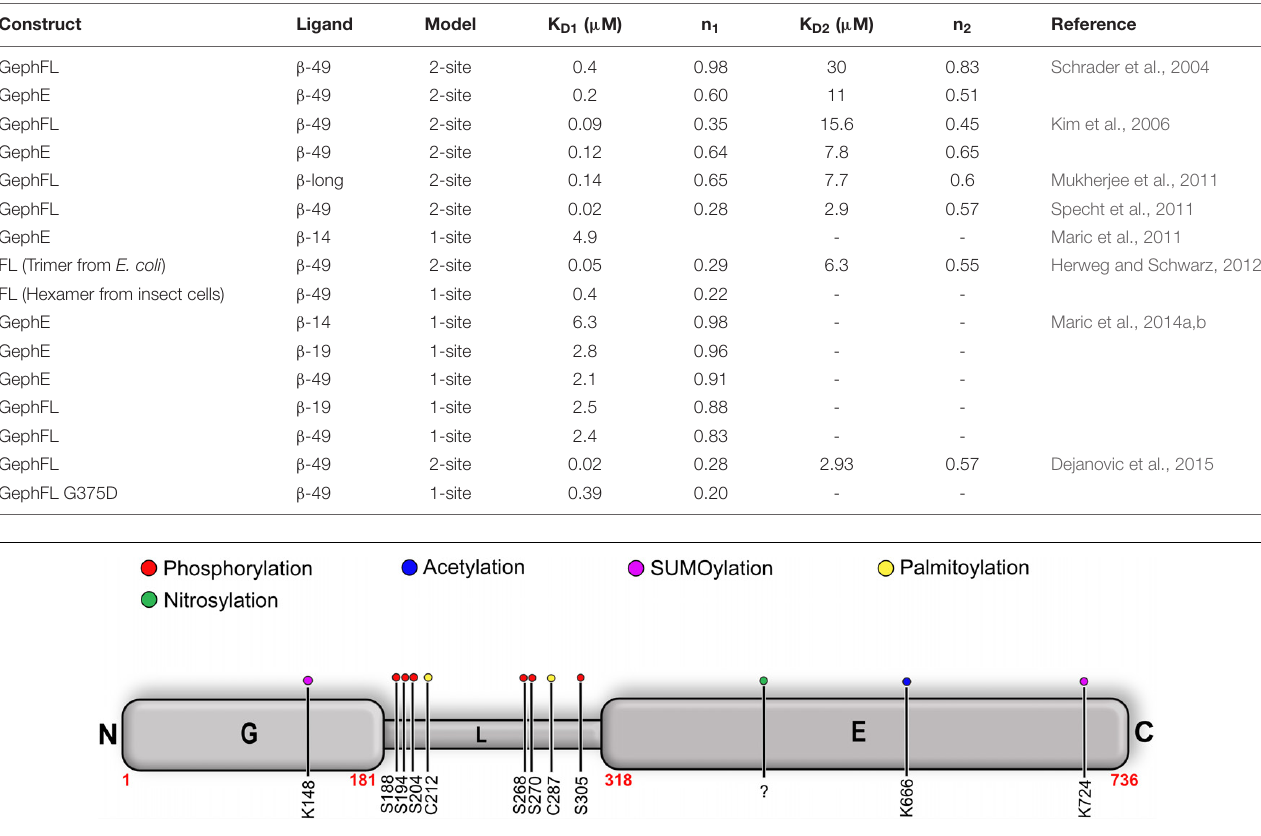
TABLE 2 | Summary of thermodynamic parameters of the gephyrin-GlyR β interaction. Construct